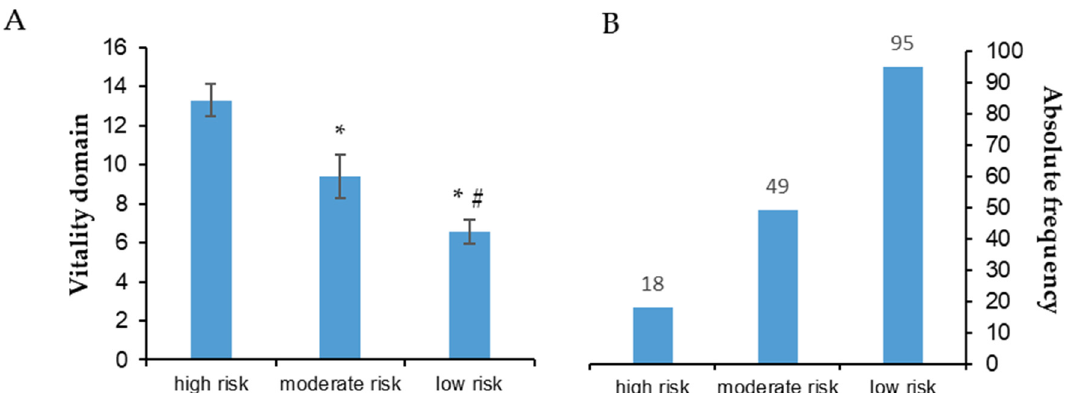
Figure 5. ( A ): Mean ± standard deviation for each risk group of the vitality domain. * p < 0.001 compared to high risk; # p = 0.002 compared to moderate risk. ( B ): Absolute frequency of older adults in each risk group.